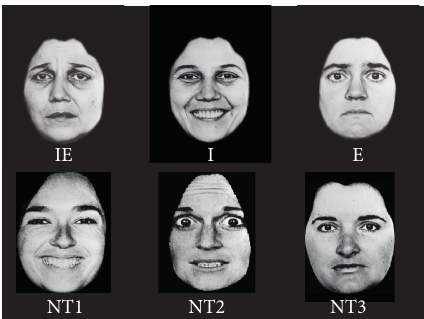
Figure 1: An example of the stimuli. IE: a face containing both the target identity and the target emotional expression; I: a face contain- ing the target identity but not the expression; E: a face containing target emotional expression; NT1-NT3 faces containing neither the target identity nor the target emotion. In this study we used faces from the NimStim database, but, because of publication restriction on faces from that database, we present here other faces (taken from Ekman and Friesen [63]) as examples